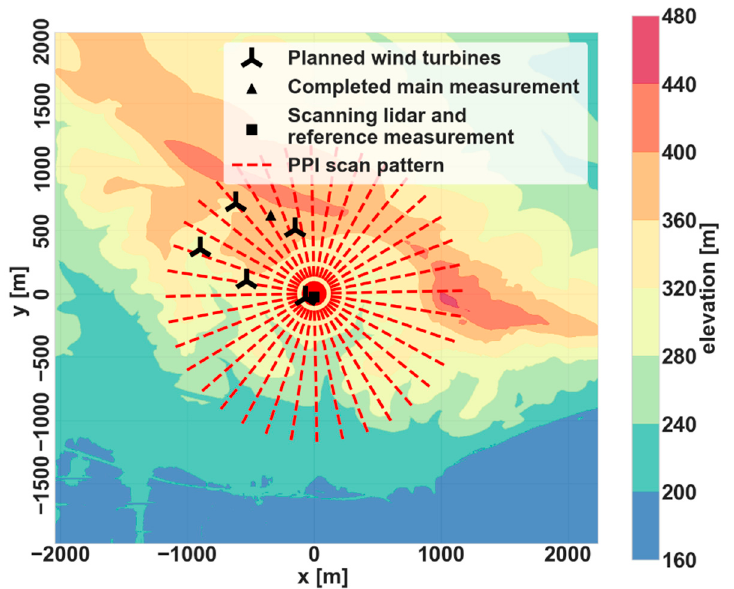
Figure 1. Elevation map of the site under study with the scanning lidar position in its center. Symbols represent the locations of wind turbines in a scenario for the wind farm Herleshausen, the lidar used for the previous wind resource assessment, and the reference sodar measurement (which is at the same position as the scanning lidar). Colors indicate terrain elevations above mean sea level—details of scan are given in Table 2.